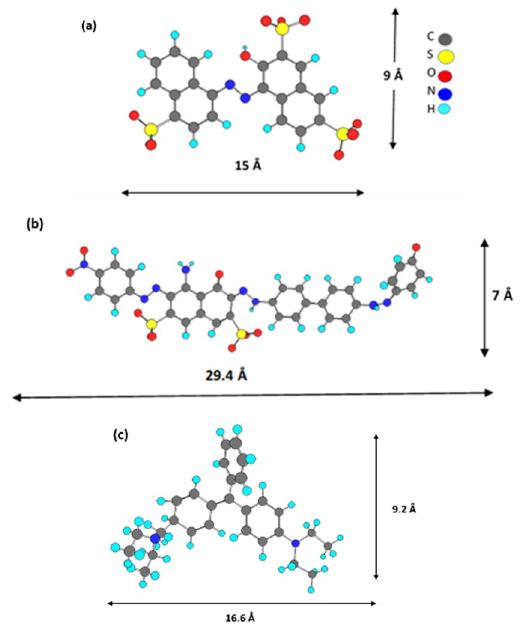
Figure 8. Chemical structure of the dyes: ( a ) Amaranth, ( b ) Diamine green B and ( c ) Brilliant green.